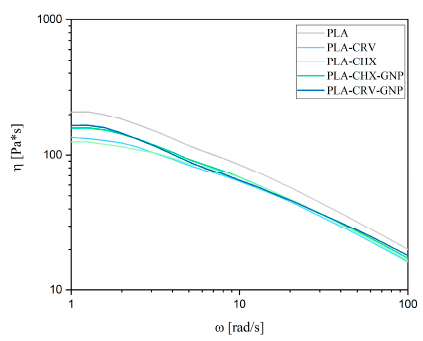
Figure 1. Complex viscosity of the polymeric solutions.